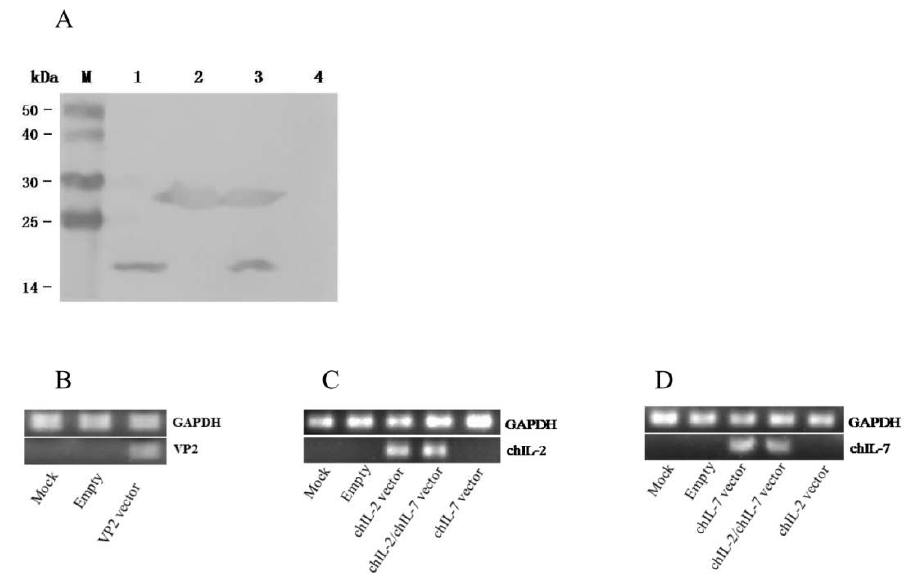
Figure 3. Detection of chIL-2 and chIL-7 expressions in vitro and in vivo. ( A ) Western blot for detection of chIL-2 and chIL-7 in the culture media of the vector-transfected HEK293T cells: M, prestained protein markers; Lane 1–4, transfected with pcDNA-chIL2/H, pcDNA-chIL7/H, pcDNA-chIL2/H-IRES-chIL7/H and pcDNA3.1A empty vector, respectively. ( B – D ) RT-PCR detection of VP2, chIL-2, and chIL-7 mRNA in the vector-injected chicken muscle tissues: GAPDH, glyceraldehyde-3-phosphate dehydrogenase as a house-keeping gene; Mock, untreated; Empty, injected with pcDNA3.1A plasmid; VP2 vector, injected with pcDNA-VP2 vector; chIL-2 vector, injected with pcDNA-chIL2 vector; chIL-2/chIL7 vector, injected with pcDNA-chIL2-IRES-chIL7 vector; chIL-7 vector, injected with pcDNA-chIL7 vector.